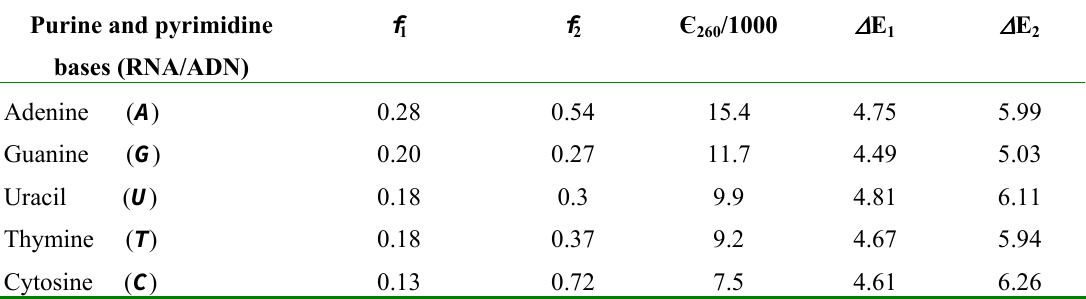
Table 1. Five properties of DNA-RNA bases using as labels to characterize each nucleotide. Experimental molar absorption coefficient Є ( ∆ E ) and second ( ∆ E ) single excitation energies in eV, and first ( f 1 2 oscillator strength values (of the first singlet excitation energies) of the nucleotide DNA- RNA bases